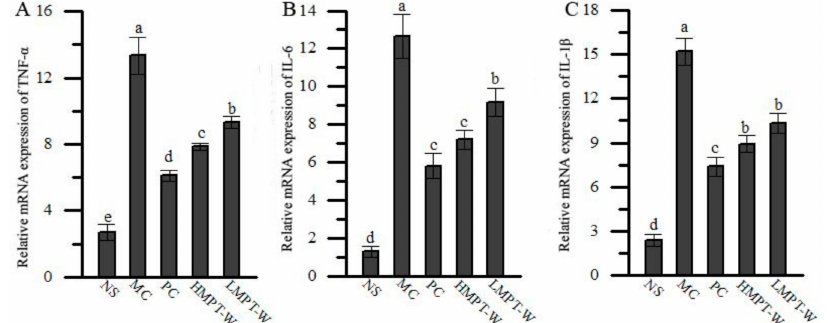
Figure 7. E ff ect of MPT-W on hepatic inflammatory cytokines in CCl 4 -induced chronic liver injury mice. ( A ) TNF- α ; ( B ) IL-6; ( C ) IL-1 β . The values are reported as means ± SD. Bars with di ff erent letters (a, b, c, d, e) are significantly di ff erent ( p < 0.05). TNF- α : tumor necrosis factor, IL-6: Interleukin-6, IL-1 β : Interleukin-1 β